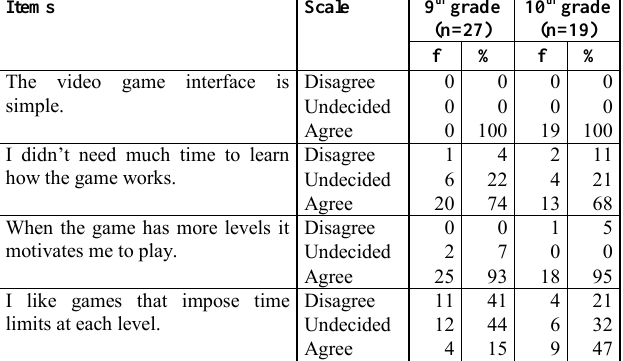
Table 9. Classroom benefits of the use of video games